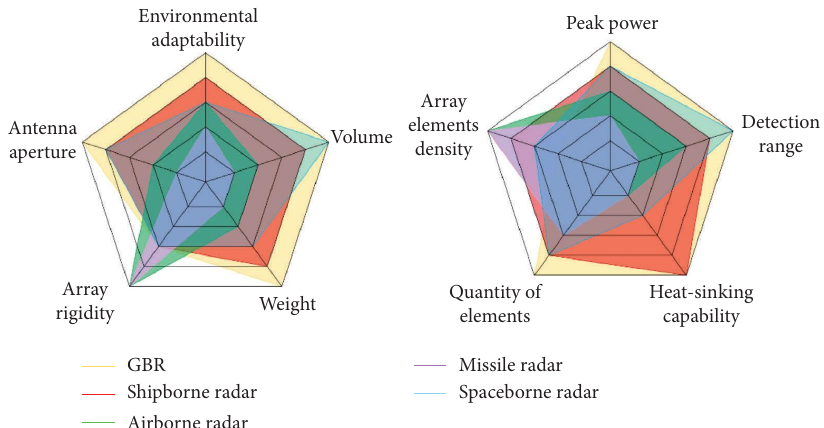
Figure 6: Characteristics of APAAs for each